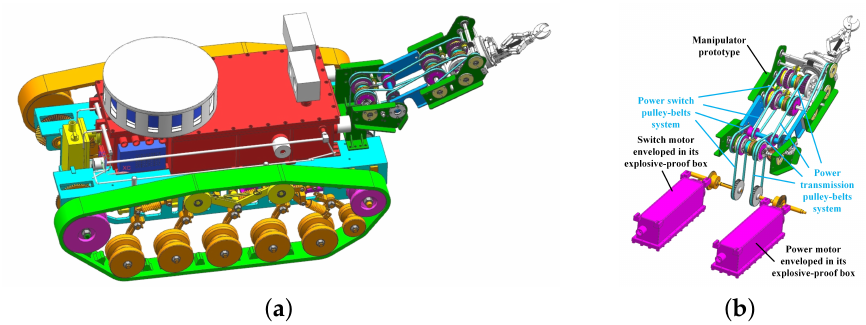
Figure 17. A 3D model of the manipulator. ( a ) The manipulator is assembled on a mobile chassis. ( b ) The manipulator structure and its power transmission system.